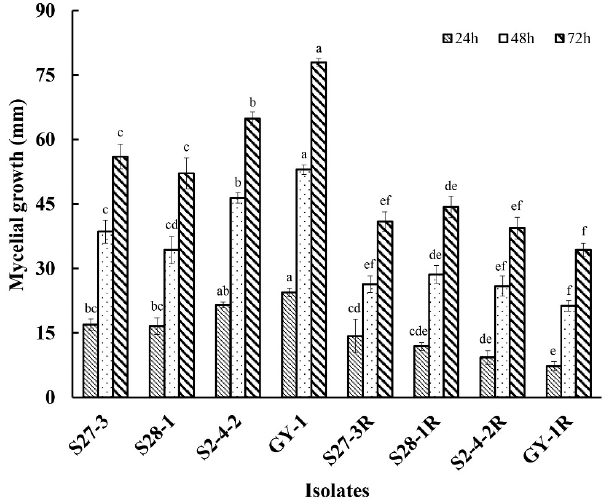
Figure 1. Mycelial growth of three pydiflumetofen-resistant mutants of F. graminearum. The average colony diameter of three resistant mutants (R) and their wild-type parental isolates was measured after 24-, 48-, and 72-h incubation on PDA at 24 ◦ C. Data are the means of eight replicates ± standard error (SE). Different lowercase letters above the columns indicate significant differences ( p ≤ 0.05) after 24, 48, and 72 h incubation according to Fisher’s least significant difference test ( p ≤ 0.05).